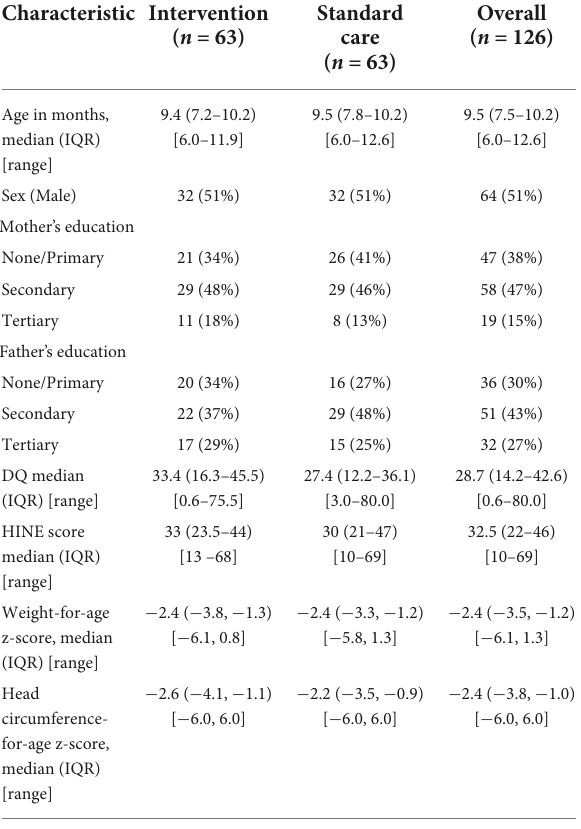
TABLE 1 Baseline characteristics of study participants by trial arm. Characteristic Intervention